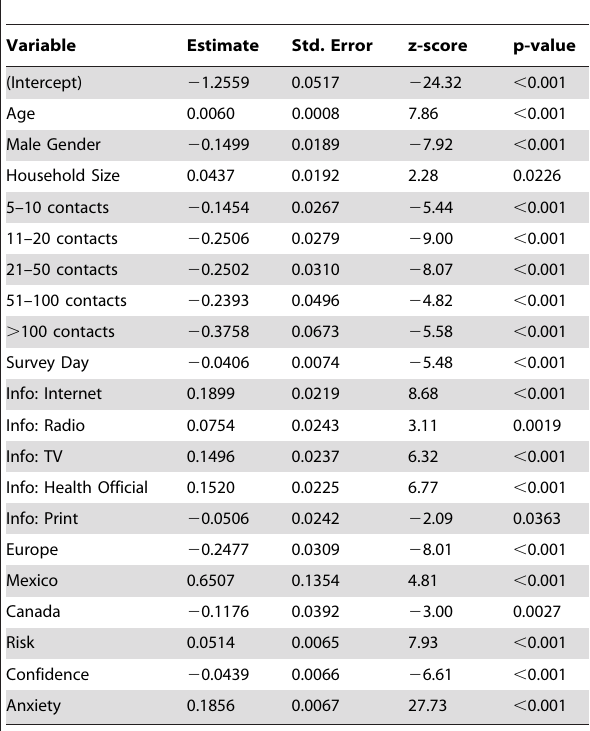
Table 2. Results of the binomial GLM for the protection index.